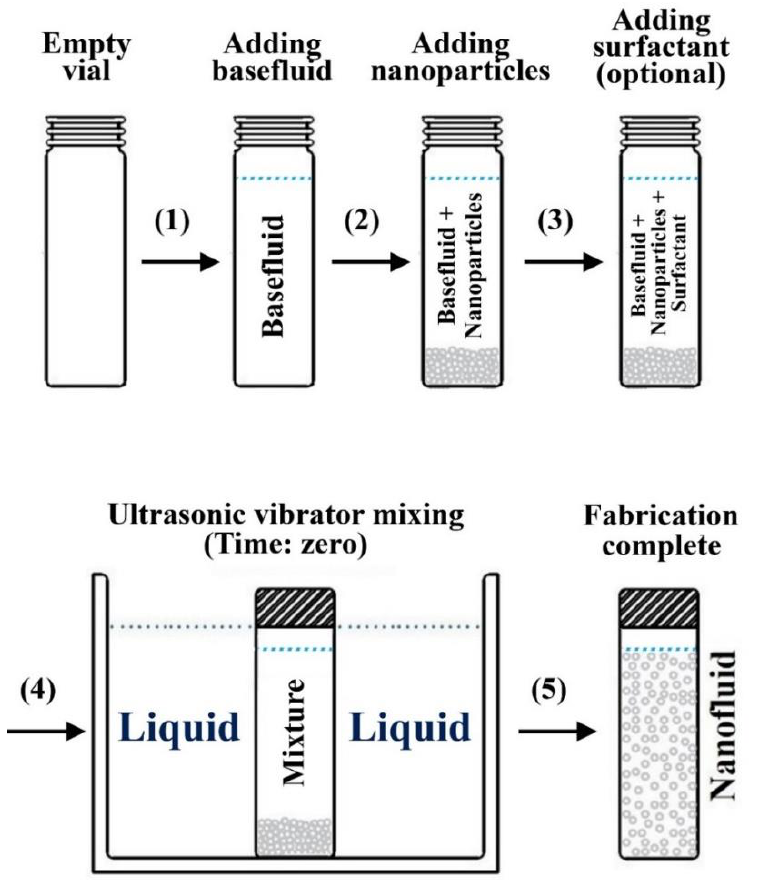
Figure 11 . Example of nanofluids two-step preparation using a bath type ultrasonic device. Figure 11. Example of nanofluids two-step preparation using a bath type ultrasonic